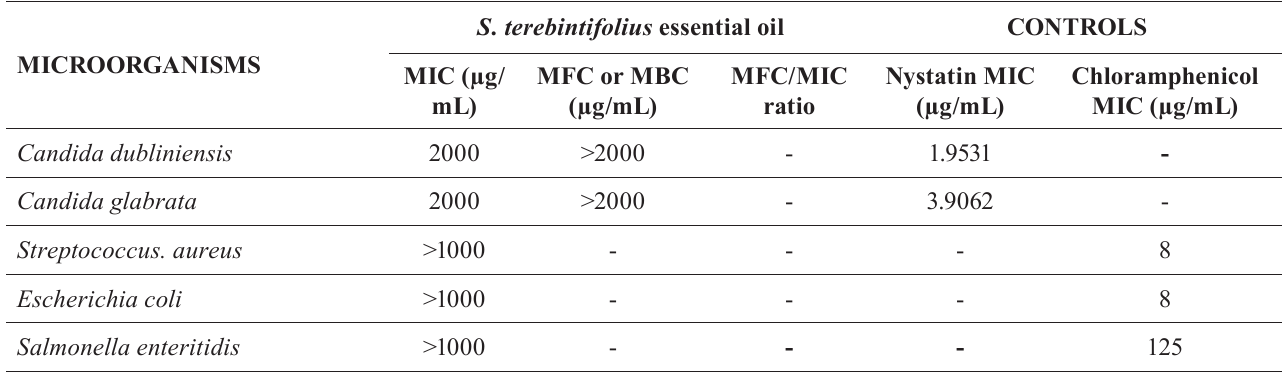
TABLE I - M inimum Inhibitory Concentration (MIC), Minimum Fungicidal (MFC) and Minimum Bactericidal (MBC) concentrations of the S. terebinthifolia green fruits EO, according to different microbial